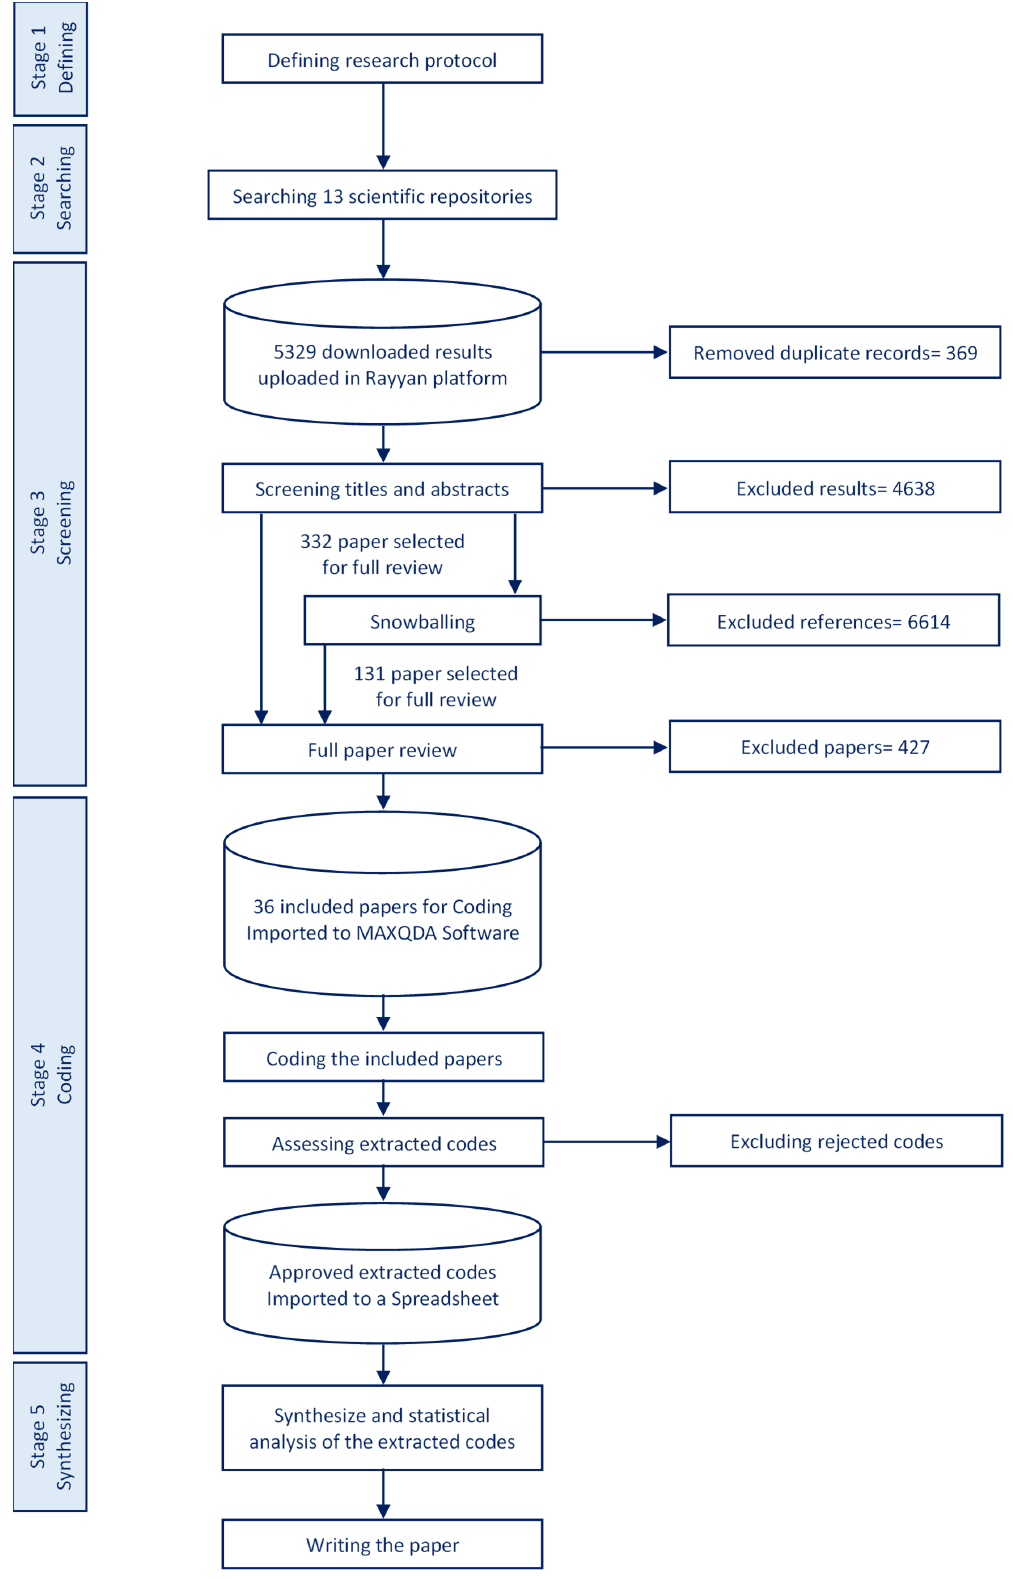
Figure 1. The SLR process flow of this